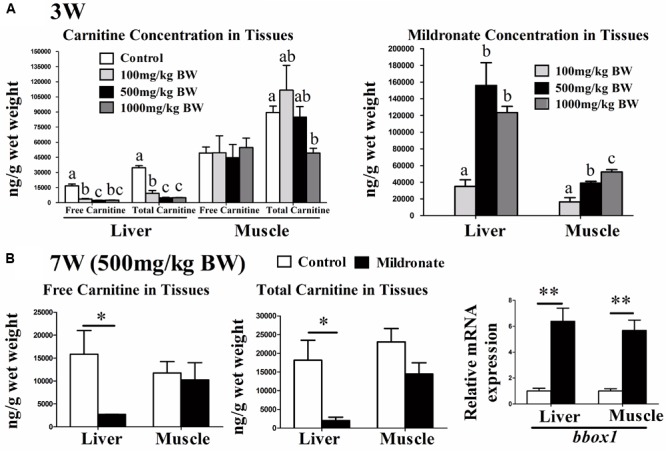
The effect of the dietary mildronate on establishing the low-carnitine zebrafish. (A) The free carnitine, total carnitine and mildronate concentration in liver and muscle after 3 weeks of the first experiment; (B) the free and total carnitine, and the mRNA expression of carnitine synthesis (bbox1) in liver and muscle after 7 week of the second experiment. All values are means ± SEM (n = 6). In A, values that are not followed by the same letter are significantly different (P < 0.05). In B, values with ∗ and ∗∗ statistically differ at P < 0.05 and P < 0.01, respectively. bbox1, butyrobetaine (gamma), 2-oxoglutarate dioxygenase (gamma-butyrobetaine hydroxylase) 1.